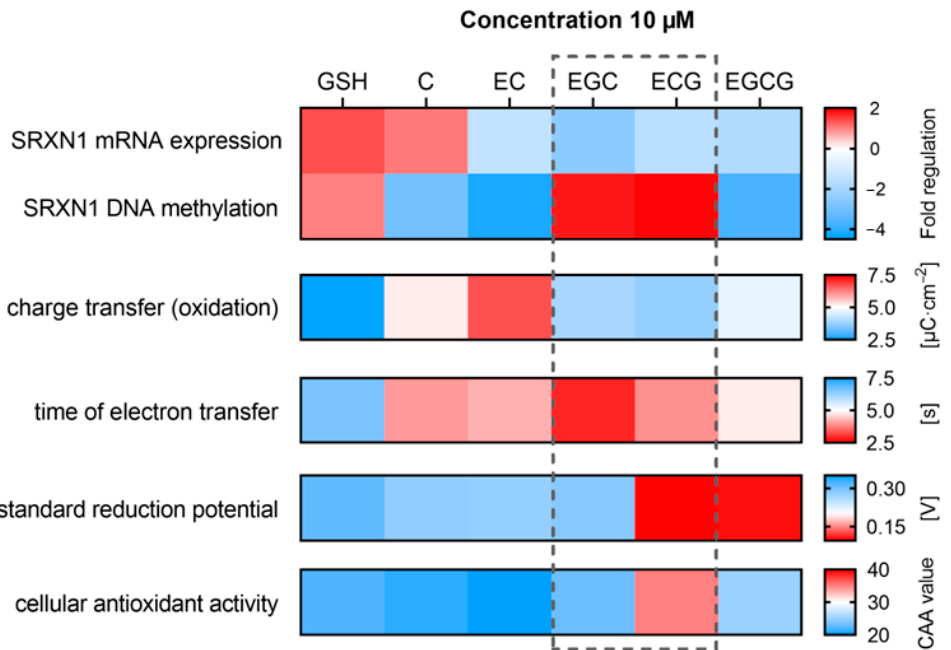
Figure 7. Heatmap representing an overview of chemical parameters of studied catechins and their effects on cellular antioxidant activity, SRXN1 mRNA expression level, and DNA methylation of SRXN1 promoter region. Abbreviations: C, (+)-catechin; CAA, cellular antioxidant activity; EC, ( − )-epicatechin; EGC, ( − )-epigallocatechin; ECG, ( − )-epicatechin gallate; EGCG, ( − )-epigallocatechin gallate; GSH, glutathione.